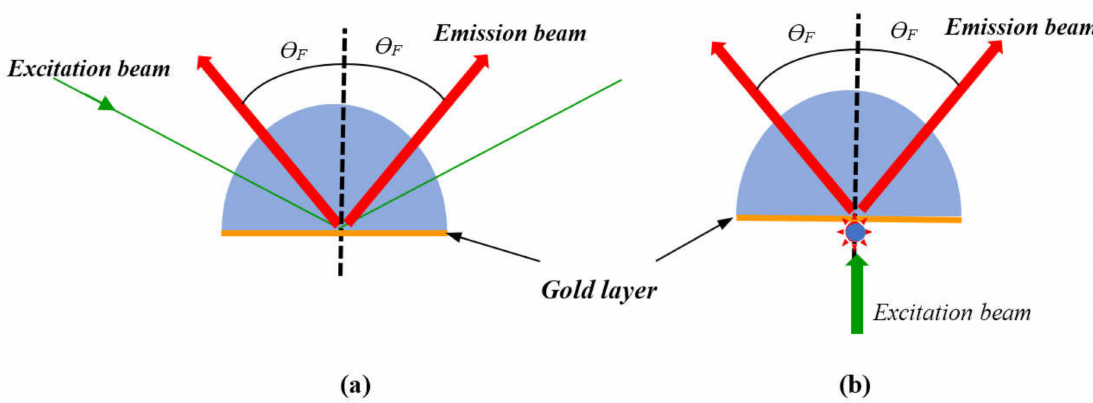
Figure 5. The surface plasmon-coupled emission set up is presented in two configurations: ( a ) Kretschmann configuration with direct excitation of surface plasmon, the light beam generates the surface plasmon wave and surface plasmon wave will excite the fluorescence; ( b ) revers Kretschmann configuration, the surface plasmon is exited using the fluorescence emitted from molecules and it excites the surface plasmon wave.